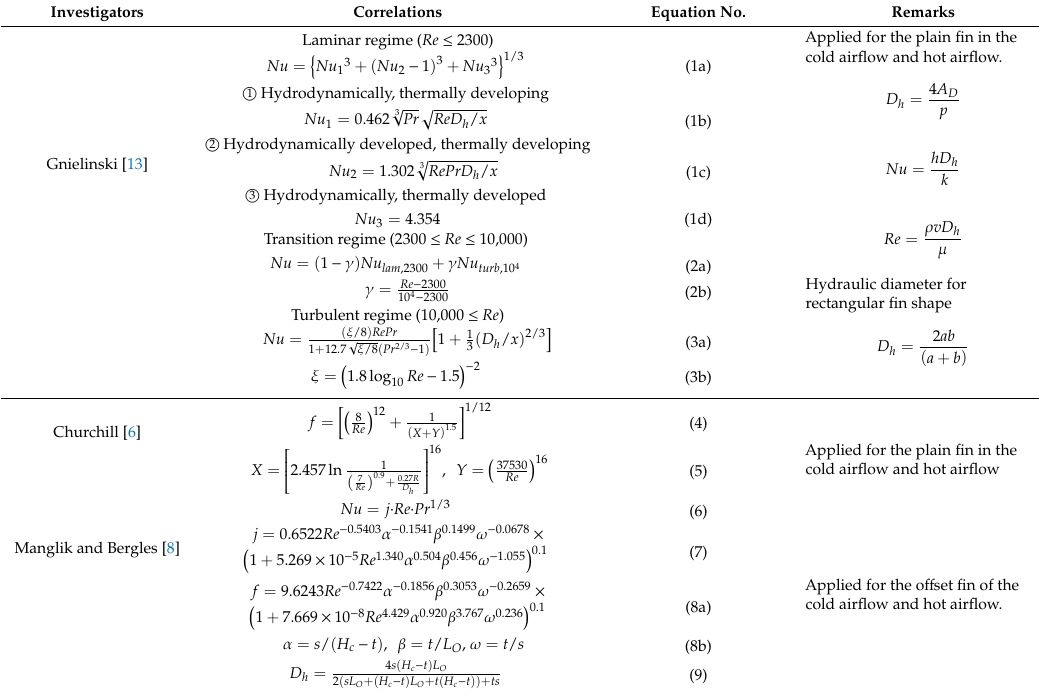
Table 2. Correlations for predicting the Nusselt number and friction factor of the heat exchanger. Investigators